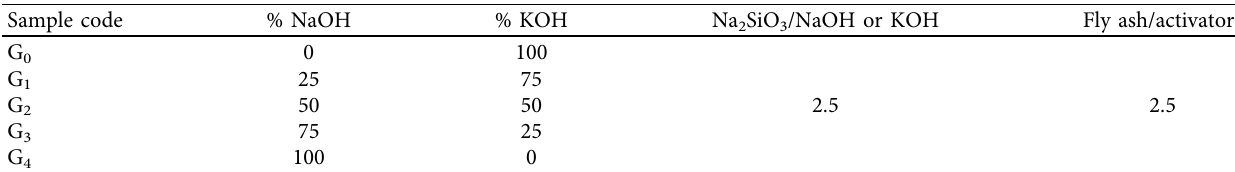
Table 2: Designation of the different geopolymer mixtures.